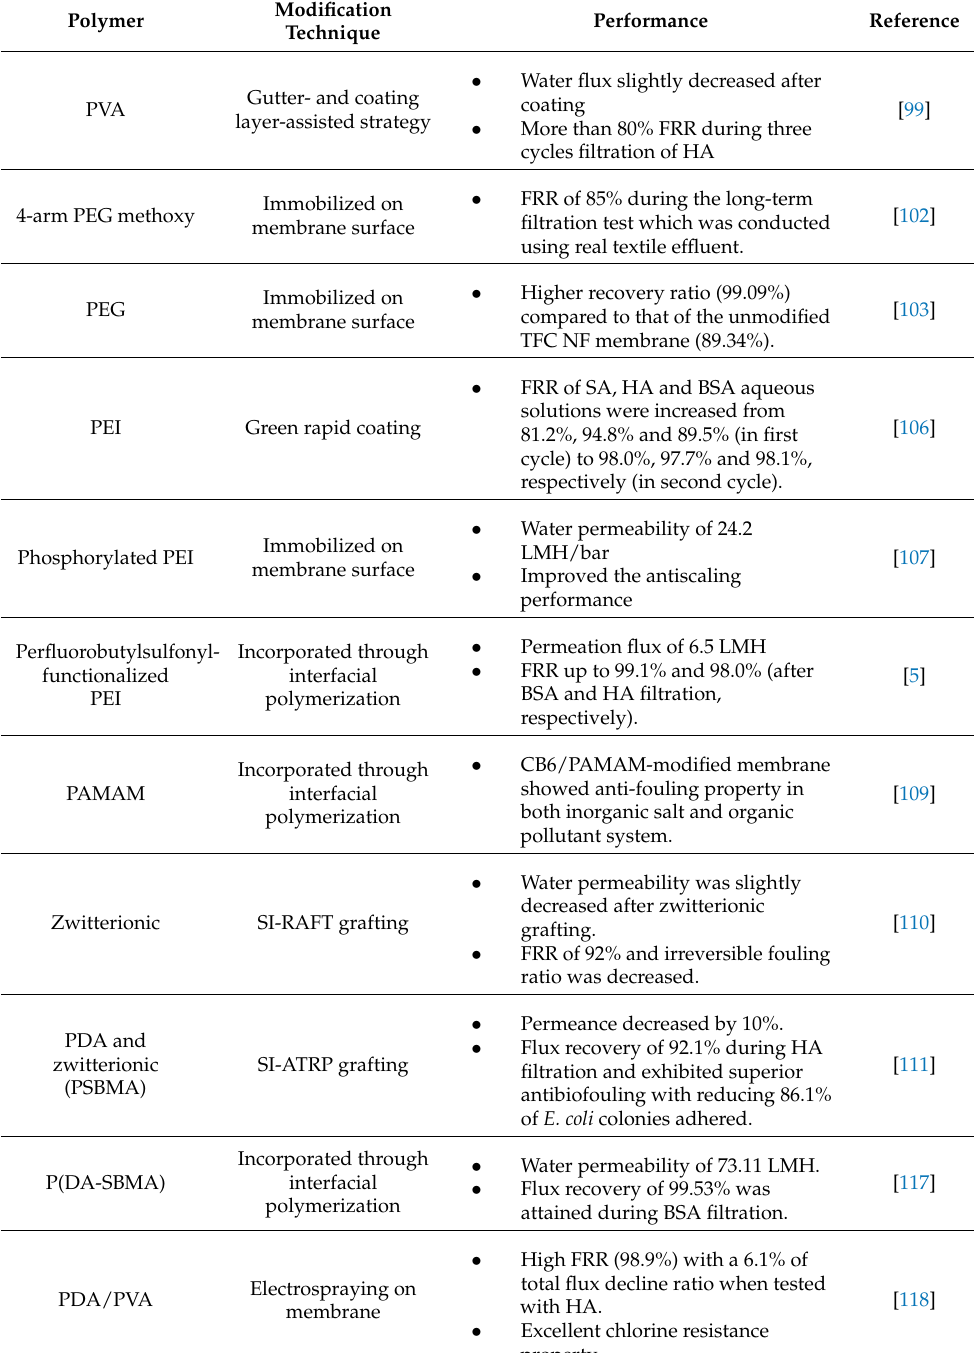
Table 2. NF modification using various types of